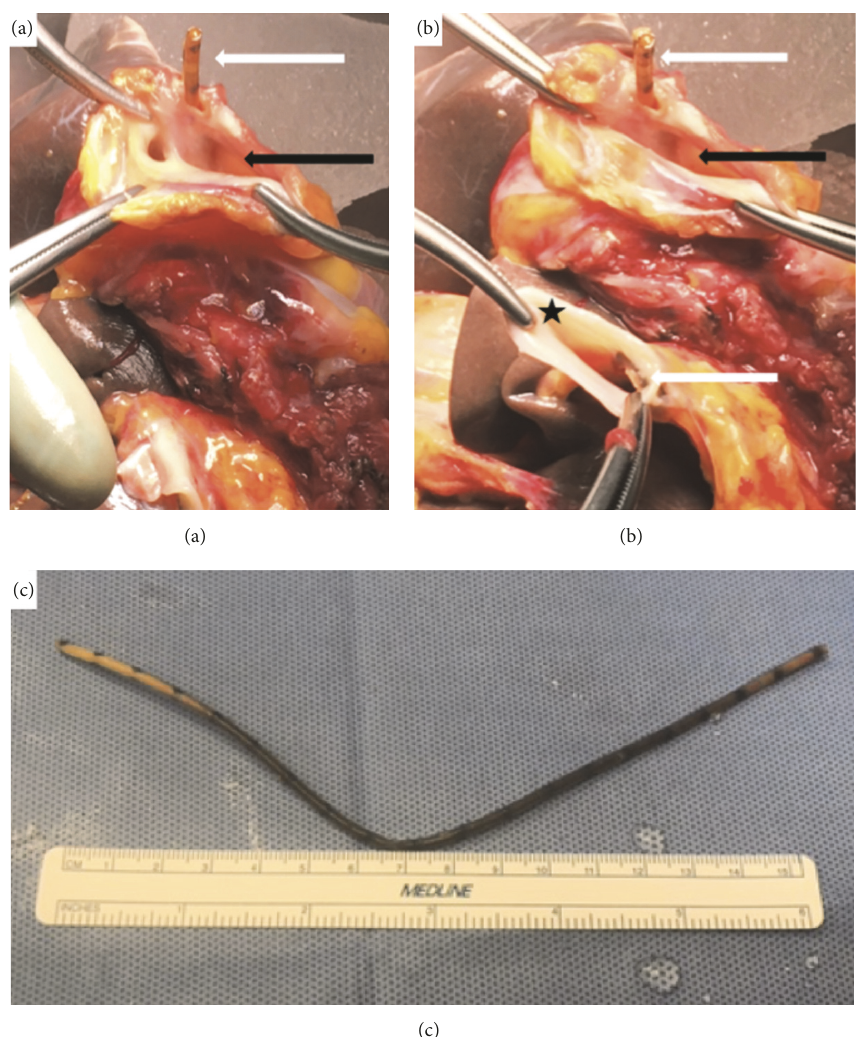
Figure 2: Retained CVC in donor liver, postprocurement. Panel (a): suprahepatic IVC. White arrow pointing at retained CVC within IVC wall. Black arrow pointing at orifice of MHV and LHV. Panel (b): white arrows pointing at retained CVC within IVC wall. Black arrow pointing at orifice of MHV and LHV. Black star at infrahepatic IVC. Panel (c): retained CVC after